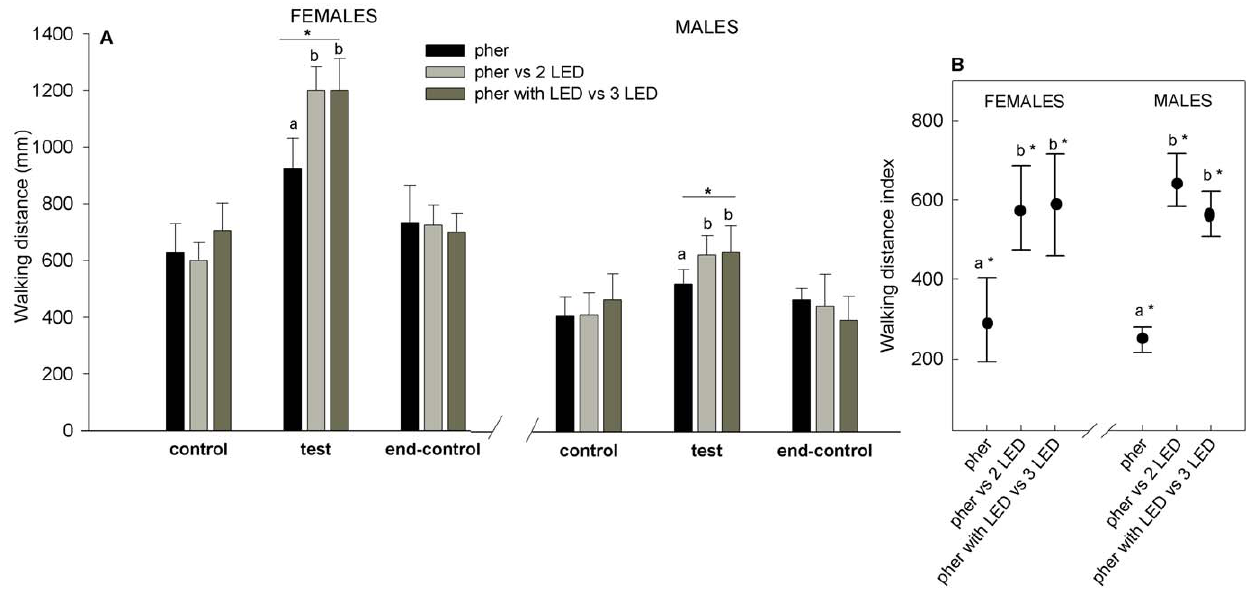
Figure 5. Walking distance of Colorado potato beetle is increased by light and pheromone. Distance walked by CPBs during stimulation with: the pheromonealone(pher), thepheromone versustwoLEDbeams ofyellowlightperpendicular totheair stream(phervs.2LED)andthepheromone plus one LEDversus three oppositeLEDbeams of yellow light: twoperpendicular and two parallel tothe air stream(pher withLEDvs.3 LED). a. Average walking distance during the three experimental periods (control, test and end-control) of females and males. Asterisks (*) over the horizontal lines indicate that distances were significantly different between the three stimulation treatments (one-way ANOVA, p , 0.01). b. Walking distance index was calculated as the average walking distance during the test period minus the average walking distance during the first control period. Asterisks (*) indicate means that are significantly different from zero (Paired t-test, p , 0.05). Different letters indicate significant pairwise differences across the different directions (Tukey- Kramer’s post-hoc tests, p , 0.05). The black filled circles mark the mean and bars below and above indicate the standard error.